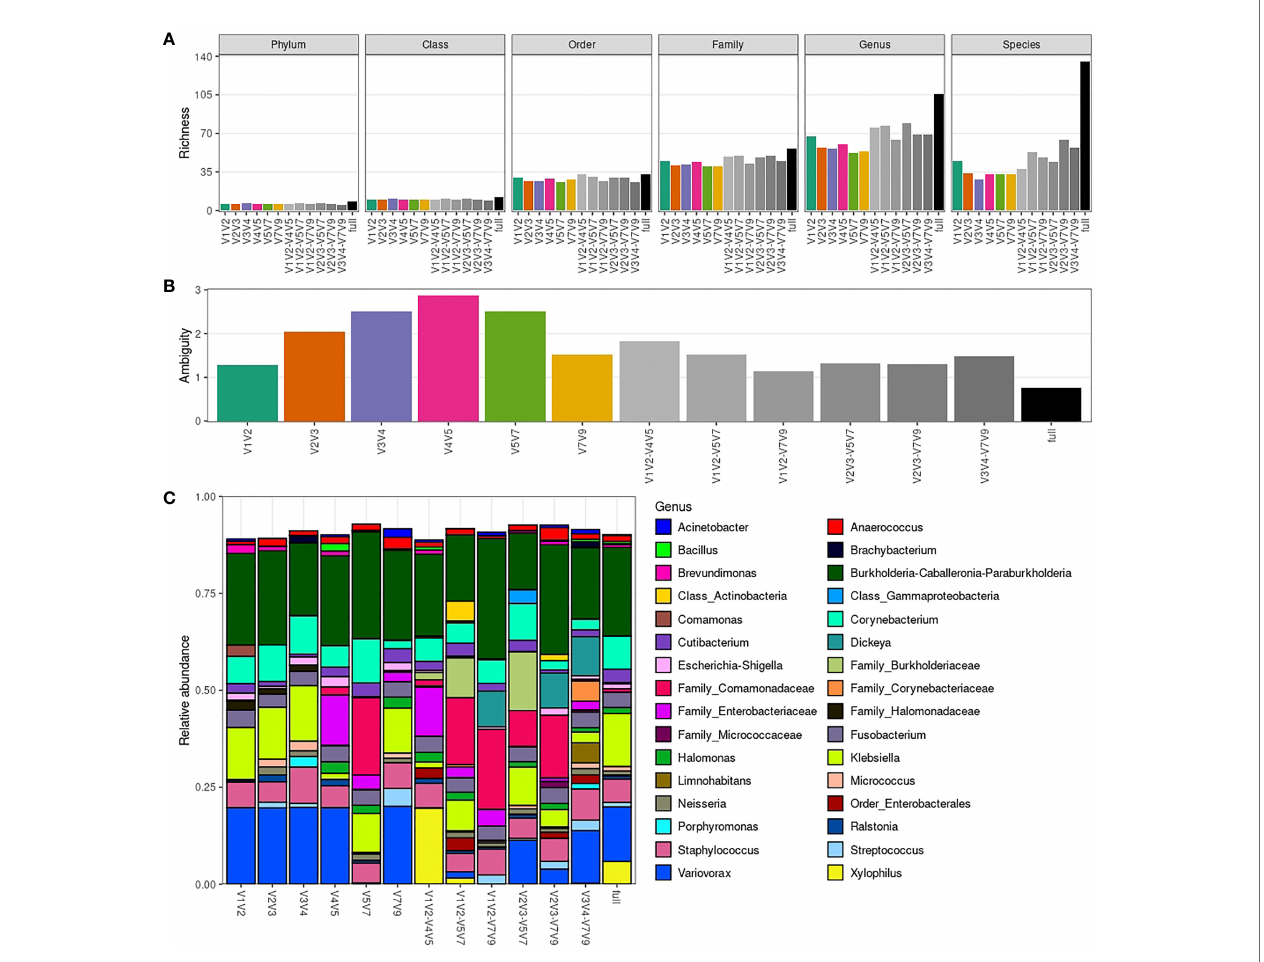
FIGURE 4 | Richness and taxonomic composition of Sidle-reconstructed datasets. (A) Taxonomic richness (phylum to species level) per amplicon-speci fi c or Sidle- reconstructed dataset. (B) Ambiguity in taxonomic assignment per amplicon-speci fi c or Sidle-reconstructed dataset. (C) Average genera relative abundance per amplicon-speci fi c or Sidle-reconstructed dataset. Only the 32 most abundant genera are shown (based on minimum relative abundance in at least one sample, which is adjusted for each